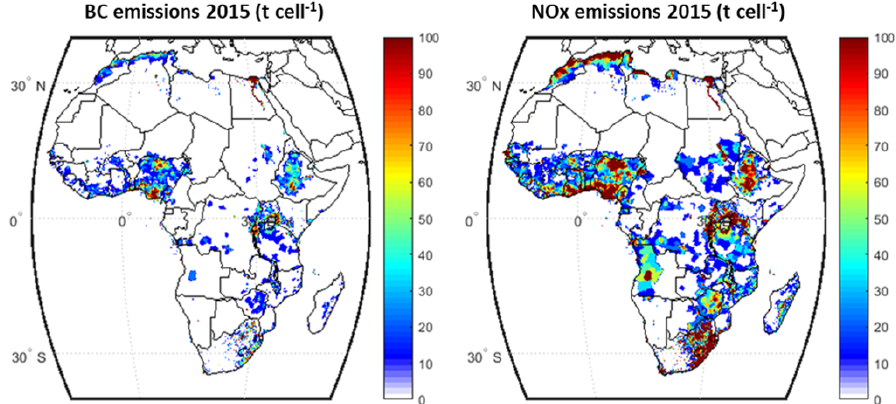
Figure 3. Spatial distribution of total anthropogenic BC and NO x emissions in 2015. Table 2. Sectoral emissions of carbonaceous particles and combustion gases in 2015 in Africa in Ggyr − 1 . 2015 (Gg)